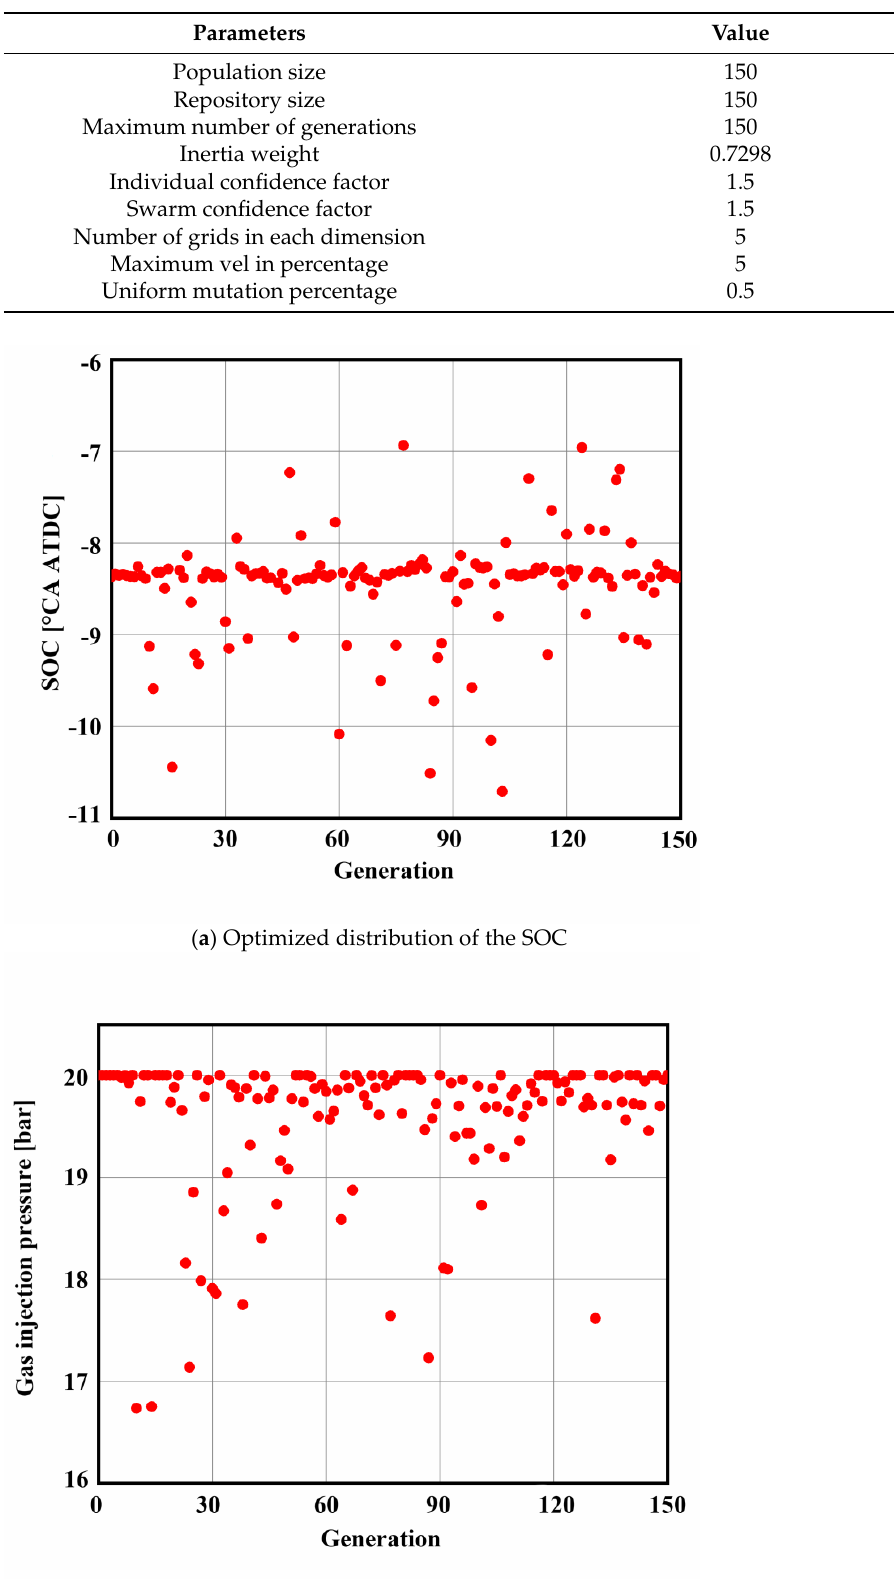
Table 7. Parameters of MOPSO.